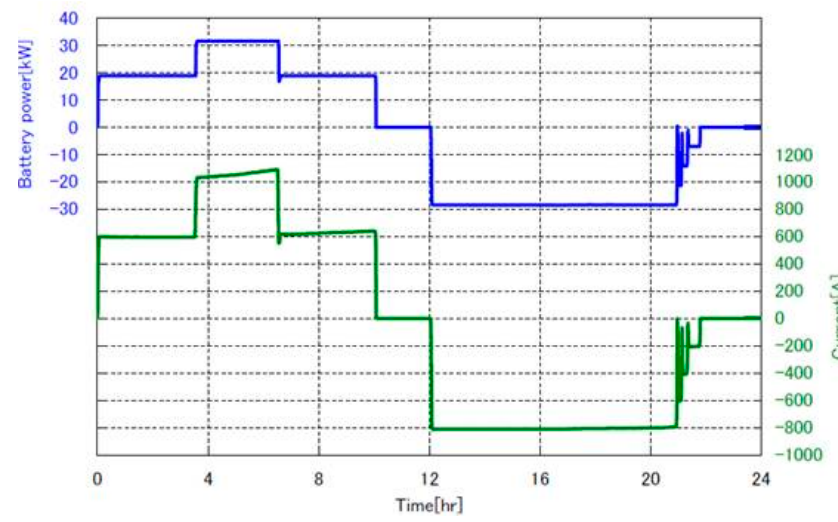
Figure 8. Current and dc power behaviour during a standard cycle in a module.